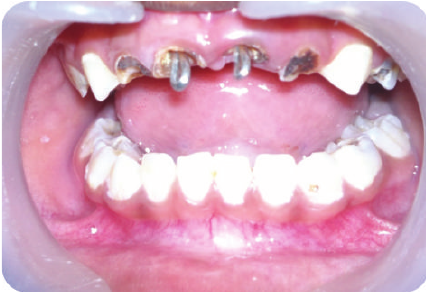
Figure 8: Clinical photographs with postinserted in 51, 61.